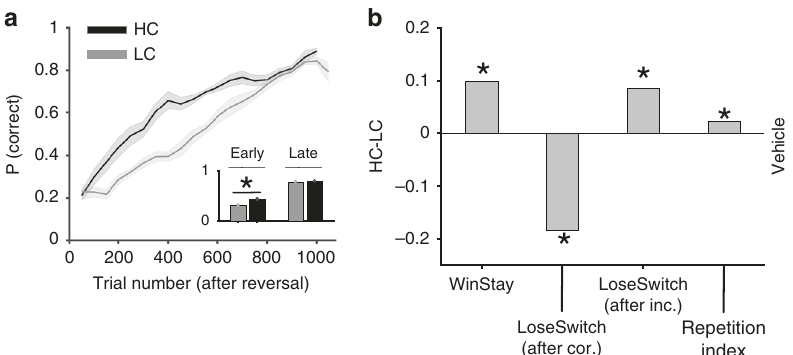
Fig. 6 In fl uence of decision con fi dence on subsequent reversal learning. a Learning curves showing performance (probability of correct response) following reversal for rats prepared with DREADDs after vehicle administration. Plots shows the performance across all rats in high-con fi dence (HC; black) and low- con fi dence (LC; gray) conditions averaged over a sliding window of 100 trials. The inset shows the average performance in early ( fi rst half of the trials) and late (last quarter of the trials) trials, demonstrating that higher con fi dence improved the rate of learning but did not change the steady state. (*) indicates a signi fi cant difference in median between the two conditions (chi-square test of ratio, p < 0.05). Error bars show the S.E.M. over sessions. b The in fl uence of con fi dence on learning strategies and perseveration. Plotted are the difference in the proportions of Win – Stay, Lose – Switch following correct but unrewarded responses, Lose – Switch after incorrect responses, and rule-based repetition index between HC and LC conditions in the fi rst half of trials after the reversal. Source data are provided as a Source Data fi